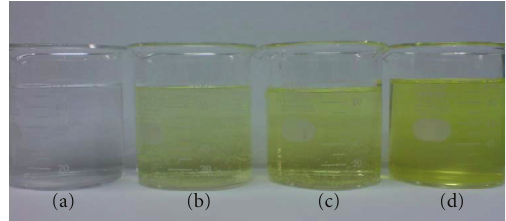
Figure 3: Color of electrolyte obtained upon Ti foil anodized in ethylene glycol containing NH 4 F and H 2 O 2 (a) before anodization process, (b) at 10 ◦ C, (c) at room temperature, and (d) at 60 ◦